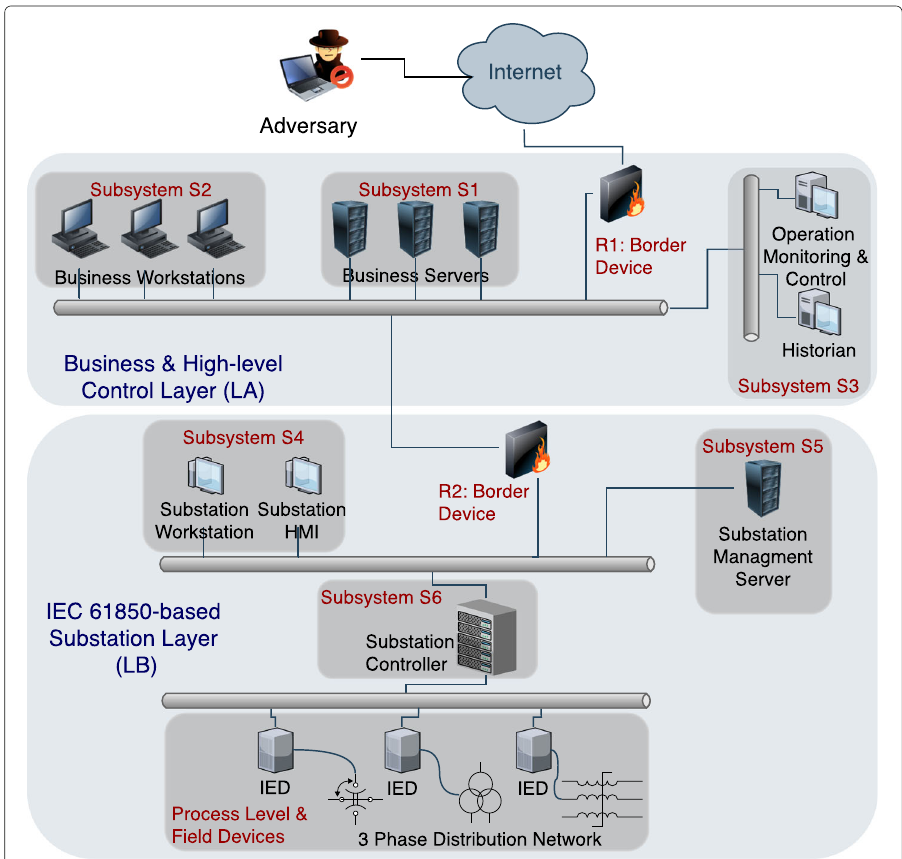
Fig. 2 A topological map of the studied electricity provider network